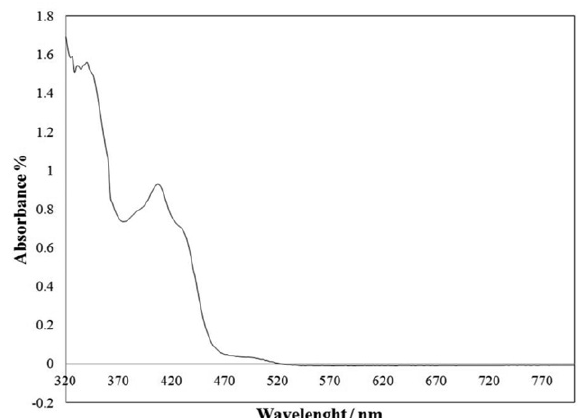
Figure 2. UV-Vis absorption spectra of 4-(4,5-Diphenyl-1H- imi- dazole-2-yl)